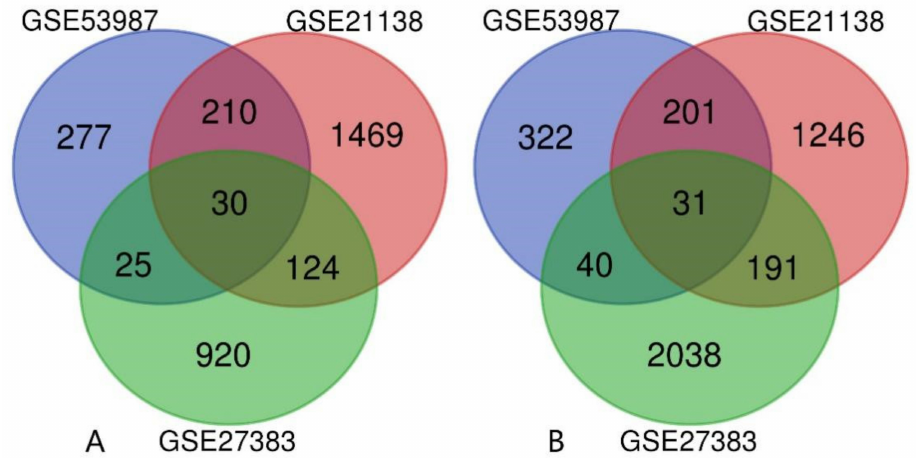
Figure 2. Venn diagram of DEGs from 3 GEO datasets. ( A ) Upregulated genes. ( B ). Downregu- lated